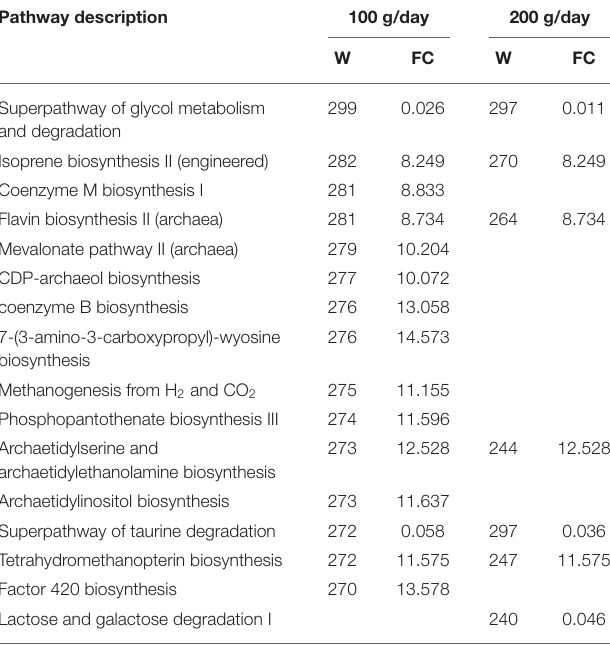
TABLE 6 | Prediction of metagenome functional content correlated with the aleurone supplementation at a level of 100 and 200 g/day using Phylogenetic Investigation of Communities by Reconstruction of Unobserved States